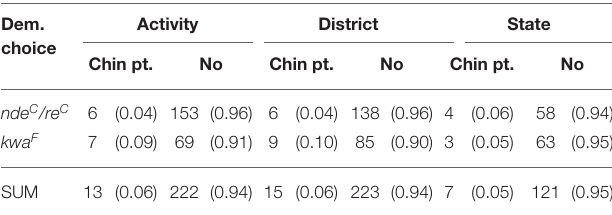
TABLE 9 | Raw frequencies (proportion) of demonstrative forms and chin points at the activity, district, and state scales. Dem. Activity District State choice Chin pt. No Chin pt. No Chin pt. No